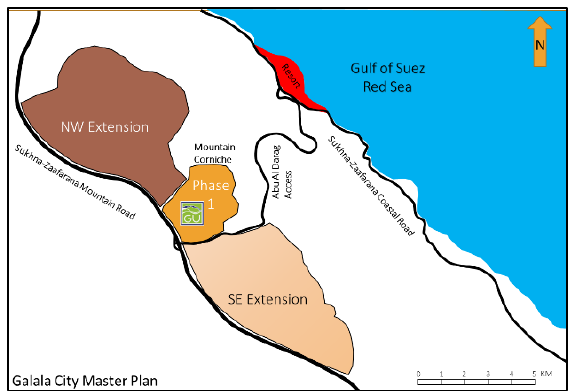
Figure 7 . Galala City Master Plan. (Source: Author)